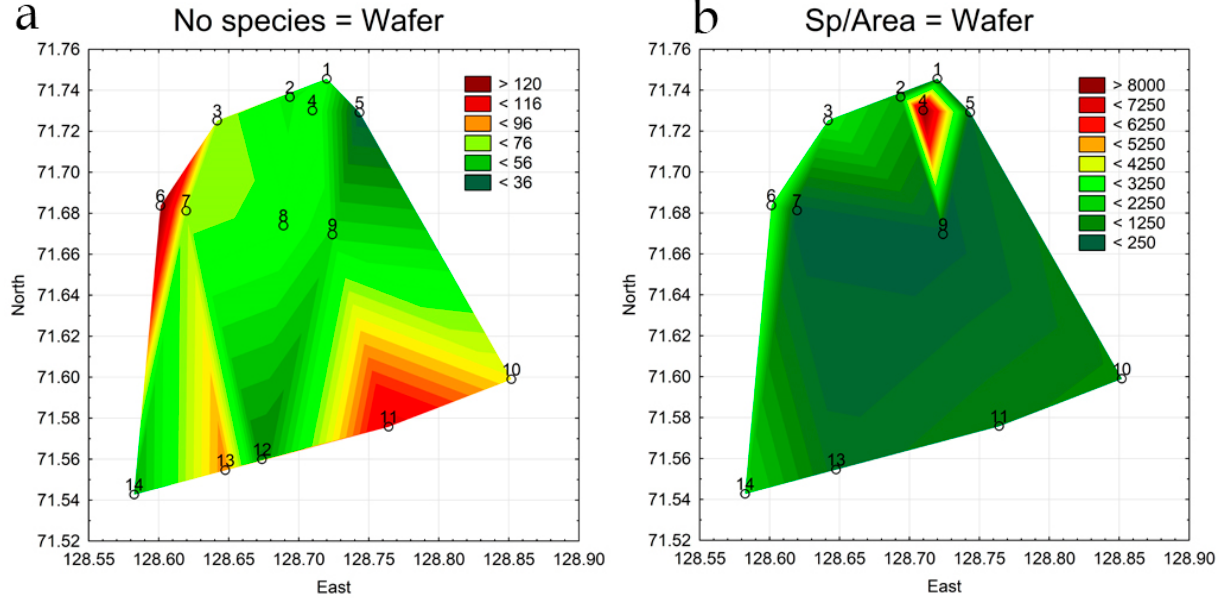
Figure 8. Statistical maps of species richness and species per area index in the 14 studied water bodies: ( a ) no. of species; ( b ) number species per area of the lake.